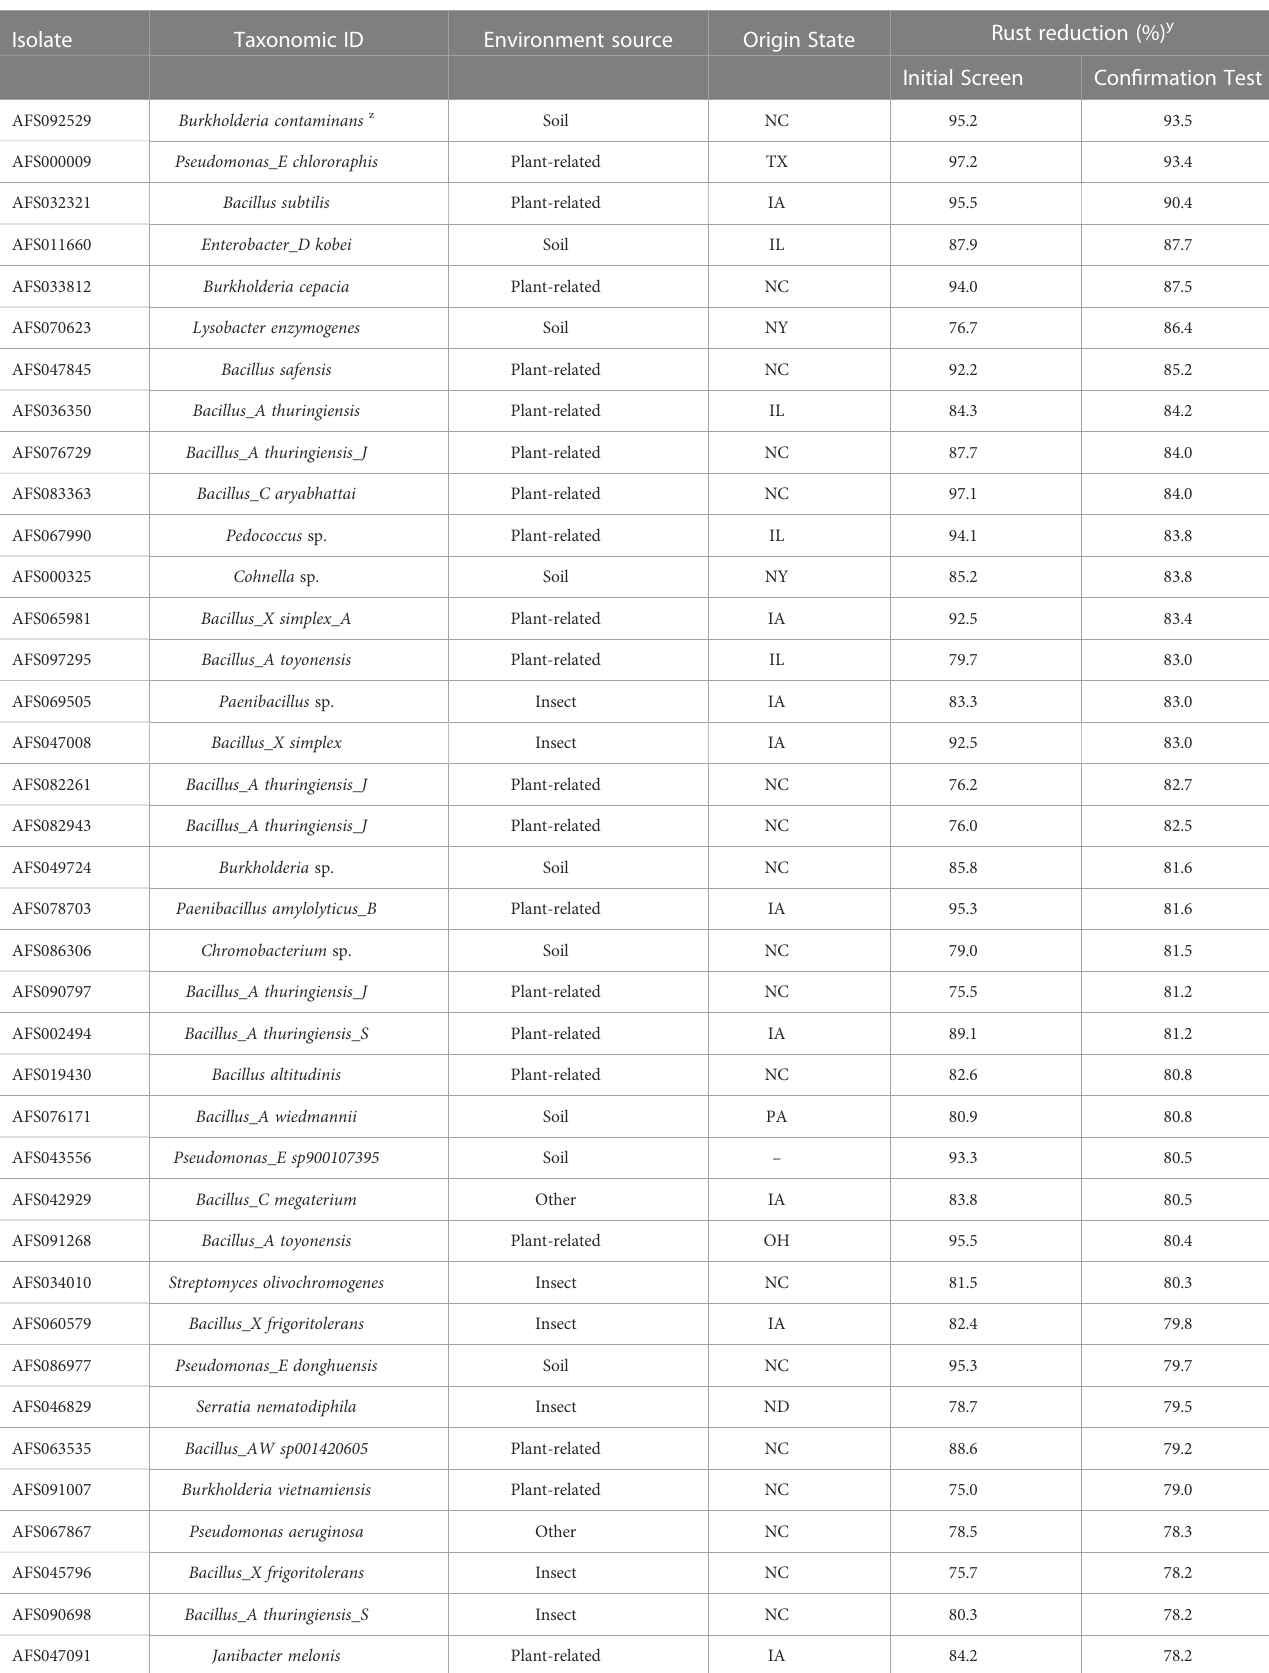
TABLE 1 Percent rust reduction by bacterial isolates selected from the initial screen and re-evaluated on-plant in the growth chamber (con fi rmation test) for their biocontrol activity against Phakopsora pachyrhizi .